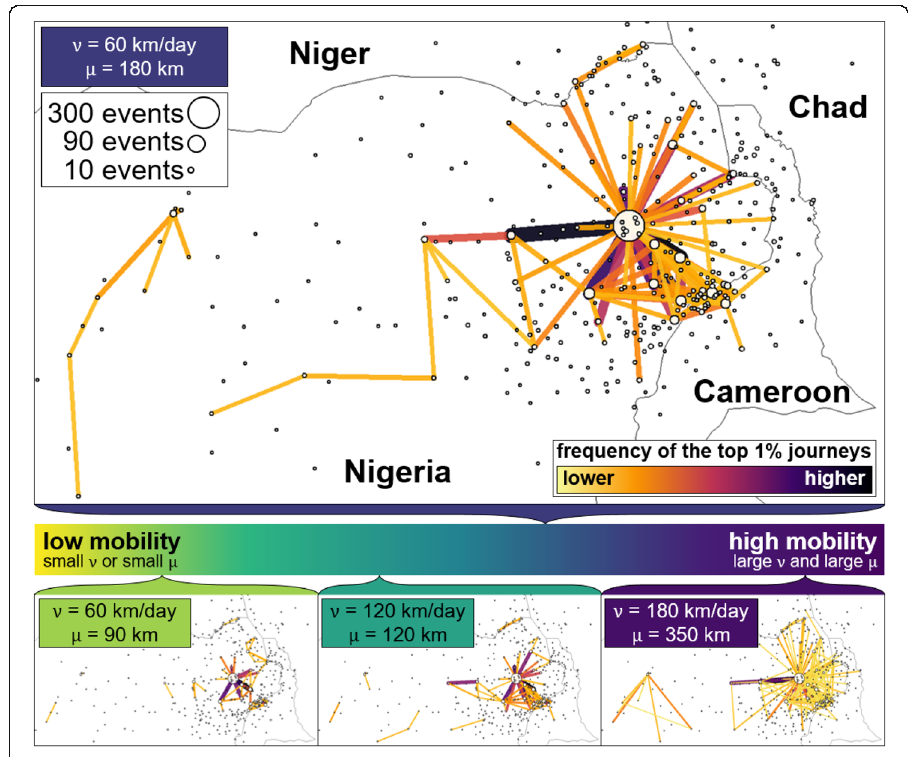
Fig. 6 The 420 nodes and the top 1% edges according to their weight for different mobility scenarios. Certain paths (between Maiduguri, which is the largest node) and the border with Cameroon and the border with Niger are travelled frequently by Boko Haram cells. Also, the journey between Maiduguri and Damaturu and Potiskum (both located west of Maiduguri) are frequently travelled with high mobility cells. With low mobility cells, the movement of Boko Haram cells is most frequently between Maiduguri and Bama, Damboa, Gwoza and Kondua, four urban agglomerations south and south-east part of